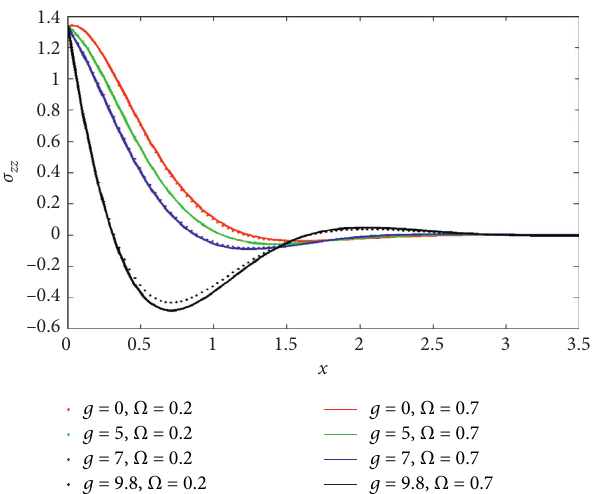
Figure 13: Stress σ